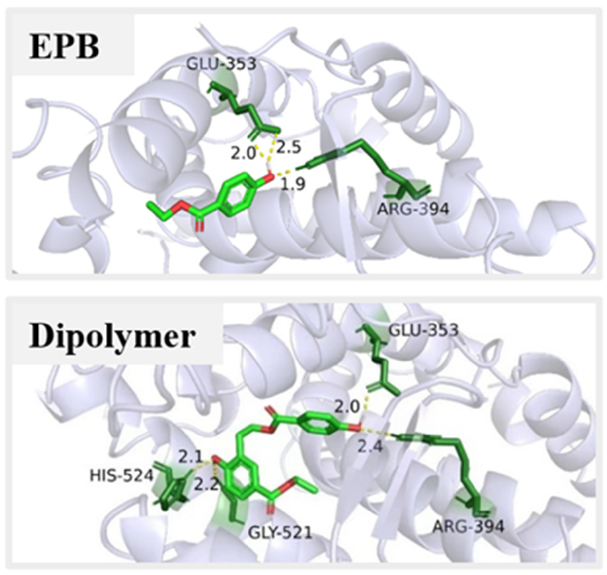
Figure 5. The docking result of EPB and product dimer with estrogen receptor α (ER α ).